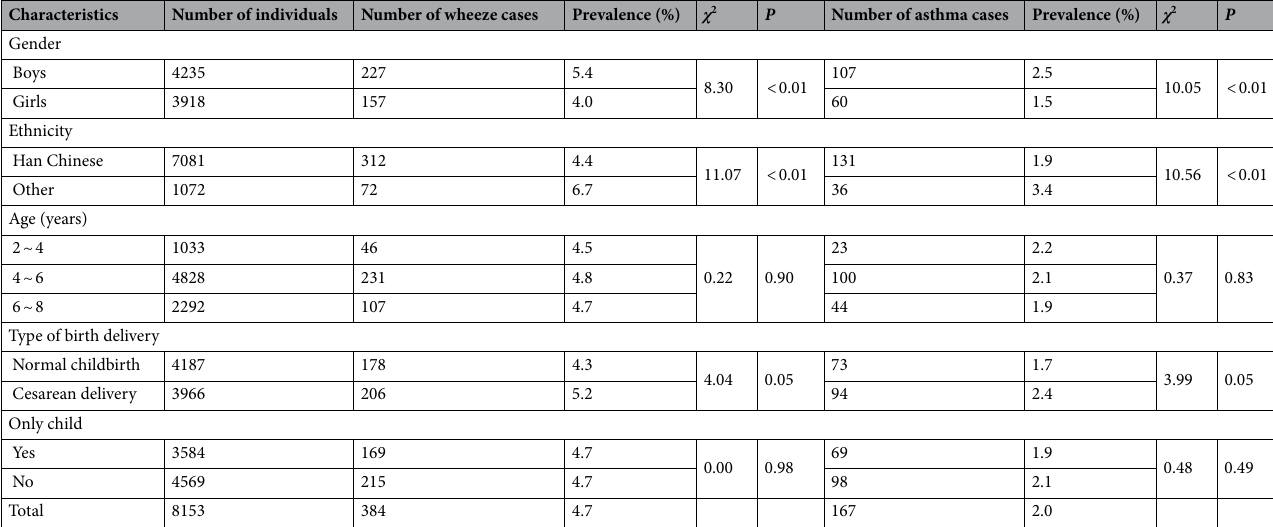
Table 1. Comparison of wheeze and asthma among preschool children with different characteristics in Urumqi ( n =